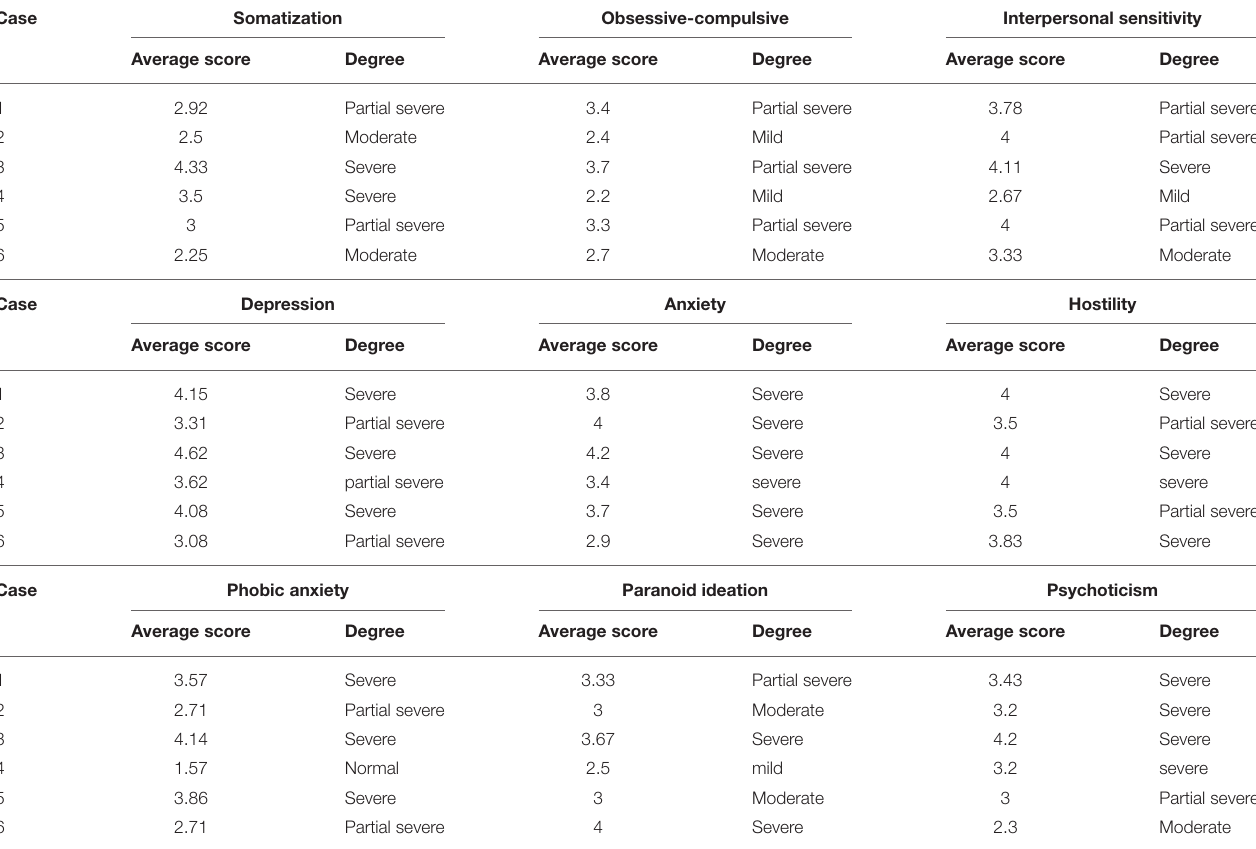
TABLE 2 | The results of psychological assessment by Symptom Checklist 90 evaluation. Case